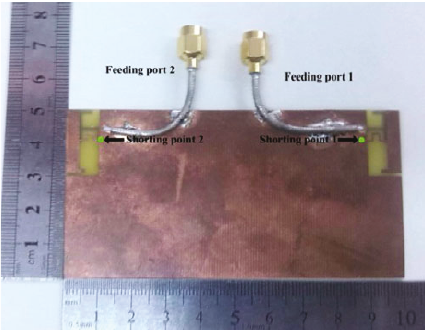
Figure 2: Photo of the antenna.